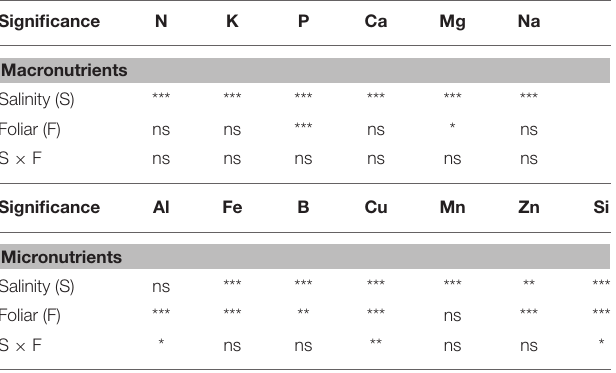
TABLE 6 | Effect of salinity levels (0–25–50–100mM NaCl) and foliar applications (no foliar, K, Zn, and Si) on the leaf analysis in lavender grown hydroponically in perlite.